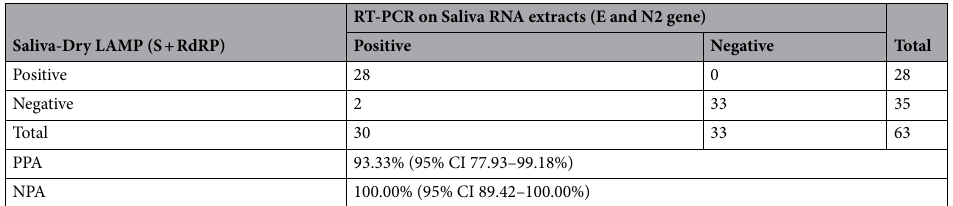
Table 3. Saliva-dry-LAMP clinical samples compared to reference RT-PCR methods (E gene and N2 gene) for saliva. Saliva-dry-LAMP was performed using commercially-available instruments and lyophilized RT-LAMP reactions from Pro-Lab Diagnostics Inc. PPA positive percent agreement, NPA negative percent agreement, S spike, RdRP RNA-dependent RNA polymerase.